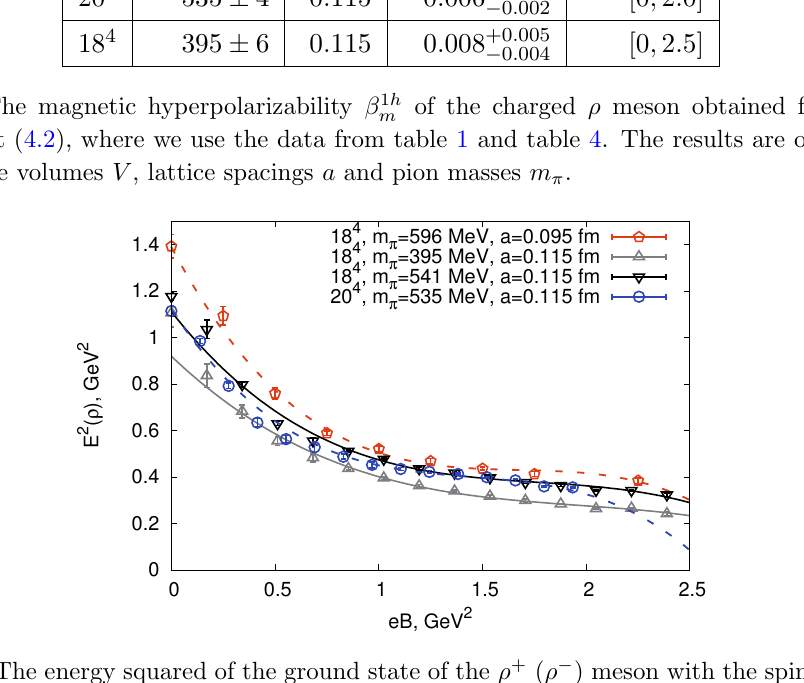
Figure 11. The energy squared of the ground state of the (cid:26) + ( (cid:26) (cid:0) ) meson with the spin projection s z = +1 ( s z = (cid:0) 1) versus the (cid:12)eld value for various sets of lattice data. The curves are the (cid:12)ts to the lattice data obtained with the use of formula